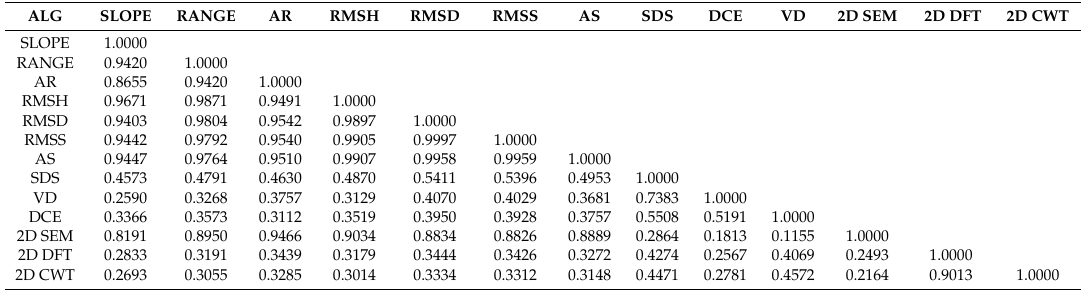
Table 3. Correlation between the extraction results of the roughness algorithm and the